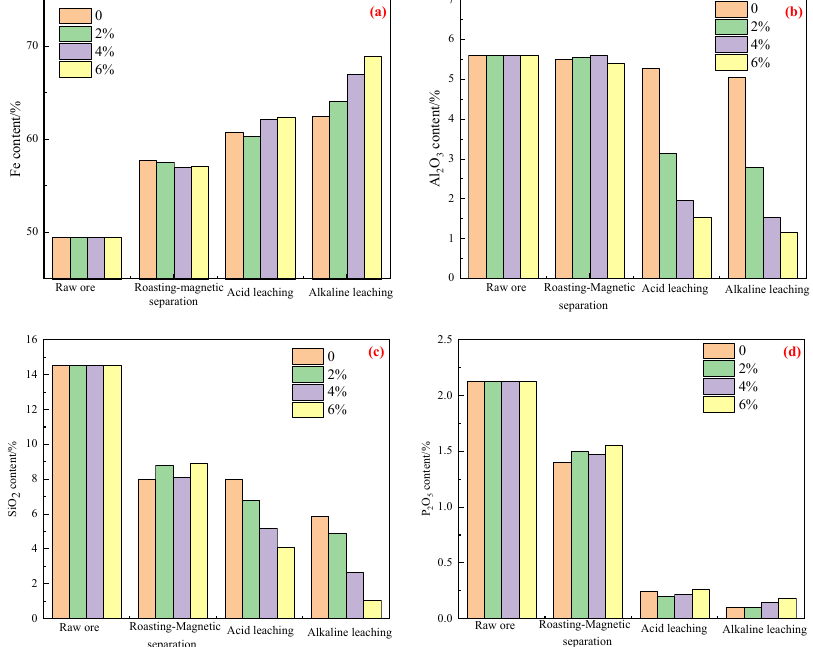
Figure 11. Enrichment of different elements in the concentrate under different NaOH dosages at different stages of beneficiation. ( a ) Fe content; ( b ) Al 2 O 3 content; ( c ) SiO 2 content; ( d ) P 2 O 5 content